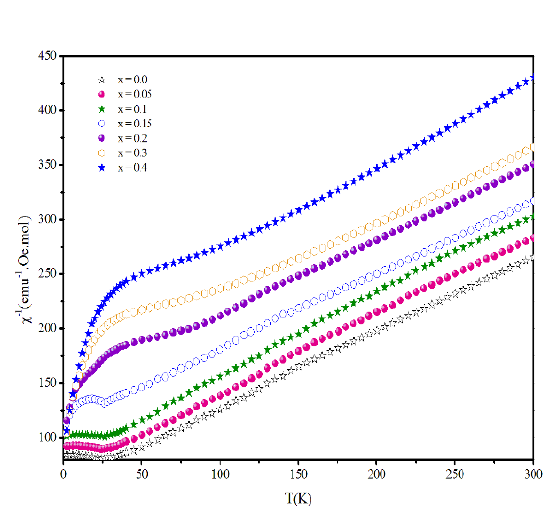
Figure 3. Williamson-Hall plot of integral line width L for different Al concentration